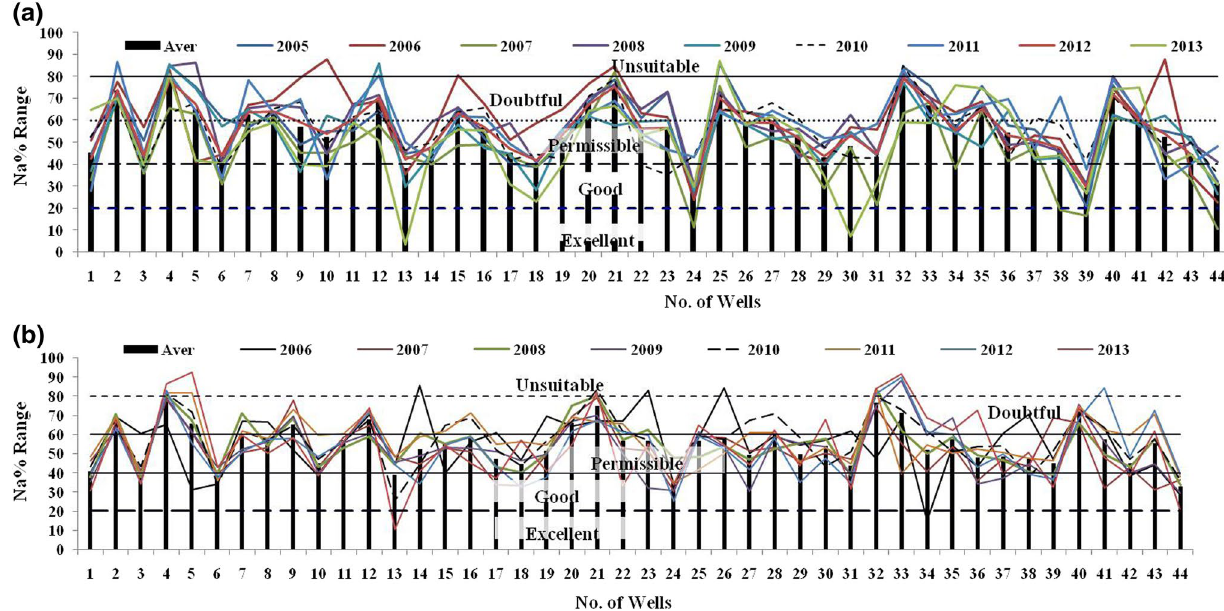
of %Na value during